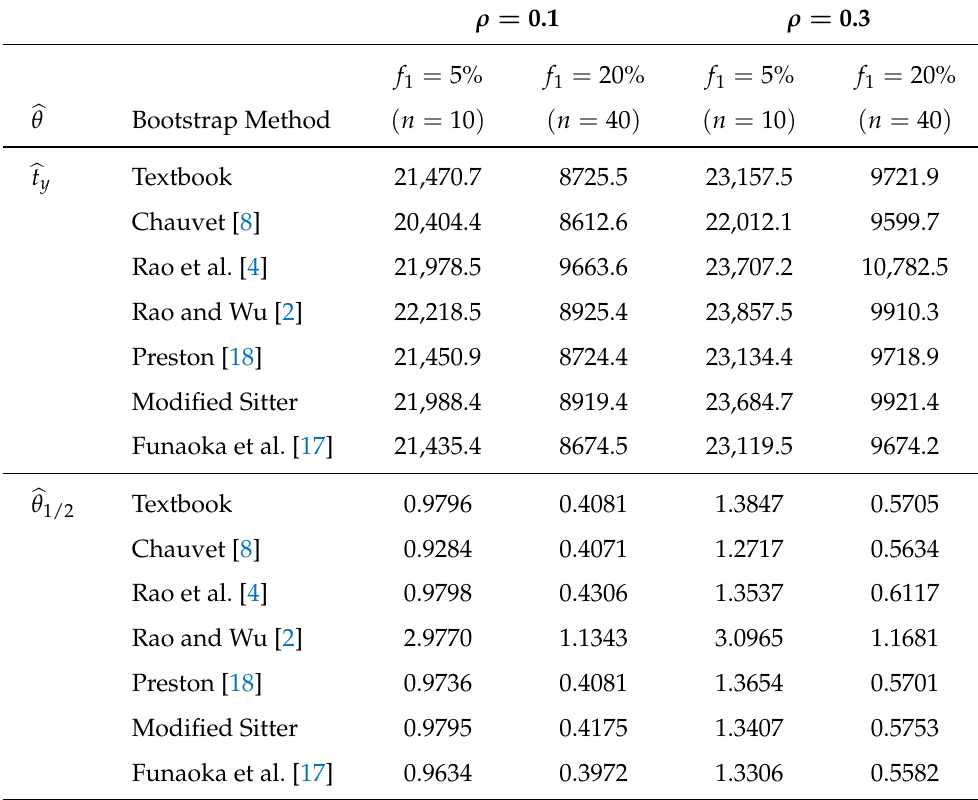
Table 5. Average length (AL) of the 95% t -distribution based confidence intervals constructed